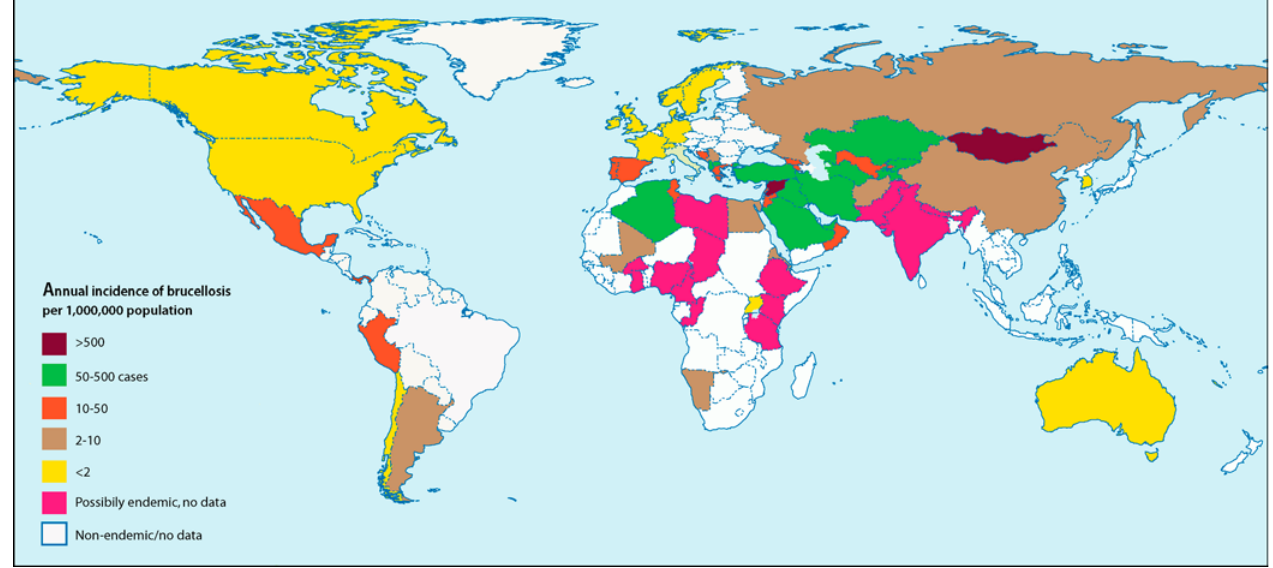
Figure 1. The Global Incidence of Human Brucellosis Reproduced from: Gutierrez Ruiz C, Miranda JJ, Pappas G (2006) A 26-year-old man with sternoclavicular arthritis. PLoS Med 3(8): e293. doi:10.1371/ journal.pmed.0030293 Derived from: Pappas G, Papadimitriou P, Akritidis N, Christou L, Tsianos EV (2006) The new global map of human brucellosis. Lancet Infect Dis 6: